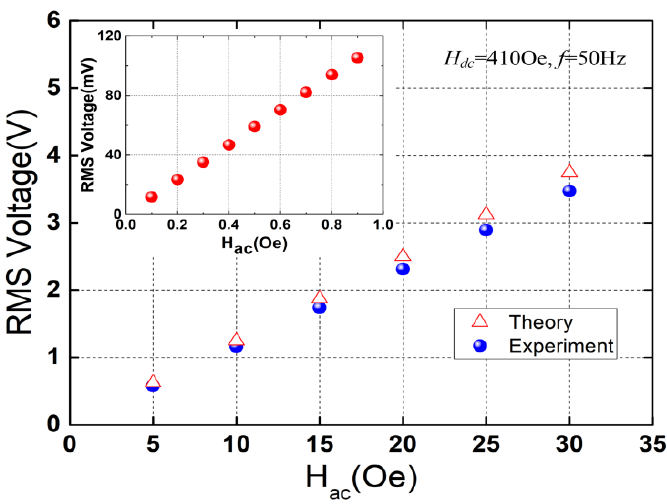
Figure 6. Open-circuit RMS voltage as a function of the applied alternating magnetic field. The inset shows the measured results below 1 Oe.